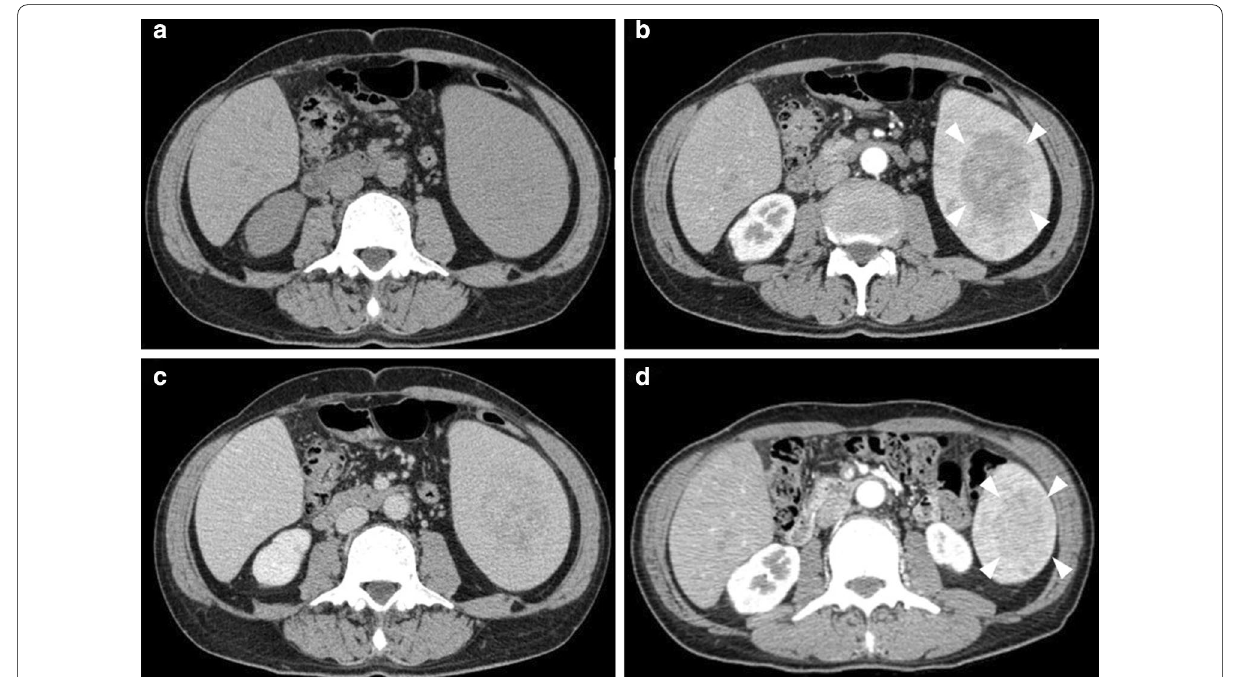
Fig. 1 Computed tomography scan of the tumor. A computed tomography scan on admission showed a 70 tumor exhibited heterogeneous hypo-enhancement during the arterial phase ( b arrowheads), and thereafter, the enhancement became gradually homogeneous in the equilibrium phase ( c ). The tumor was 45